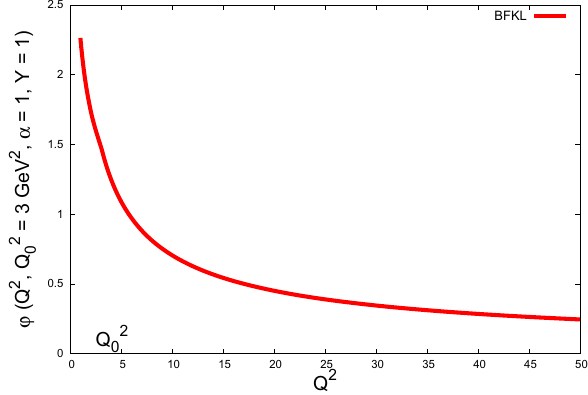
Fig. 1 Initial condition vector φ 0 and N = 50